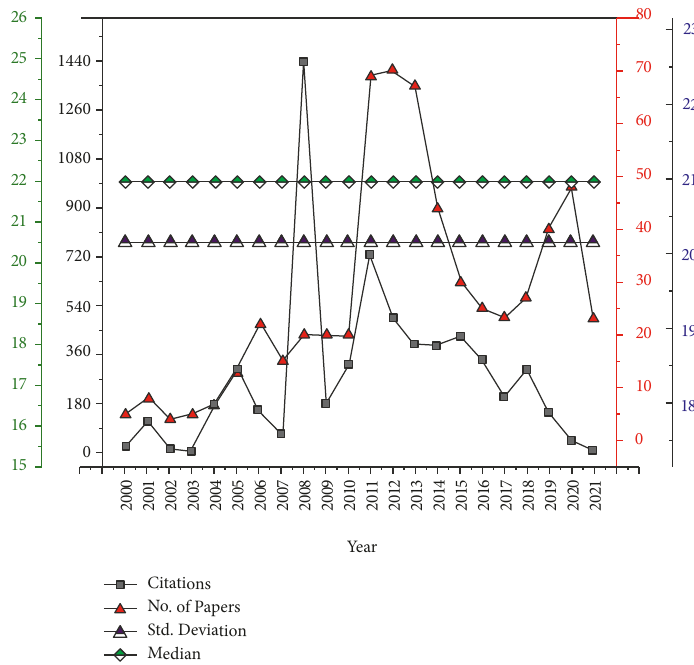
Figure 10: Publication trend from 2000 to